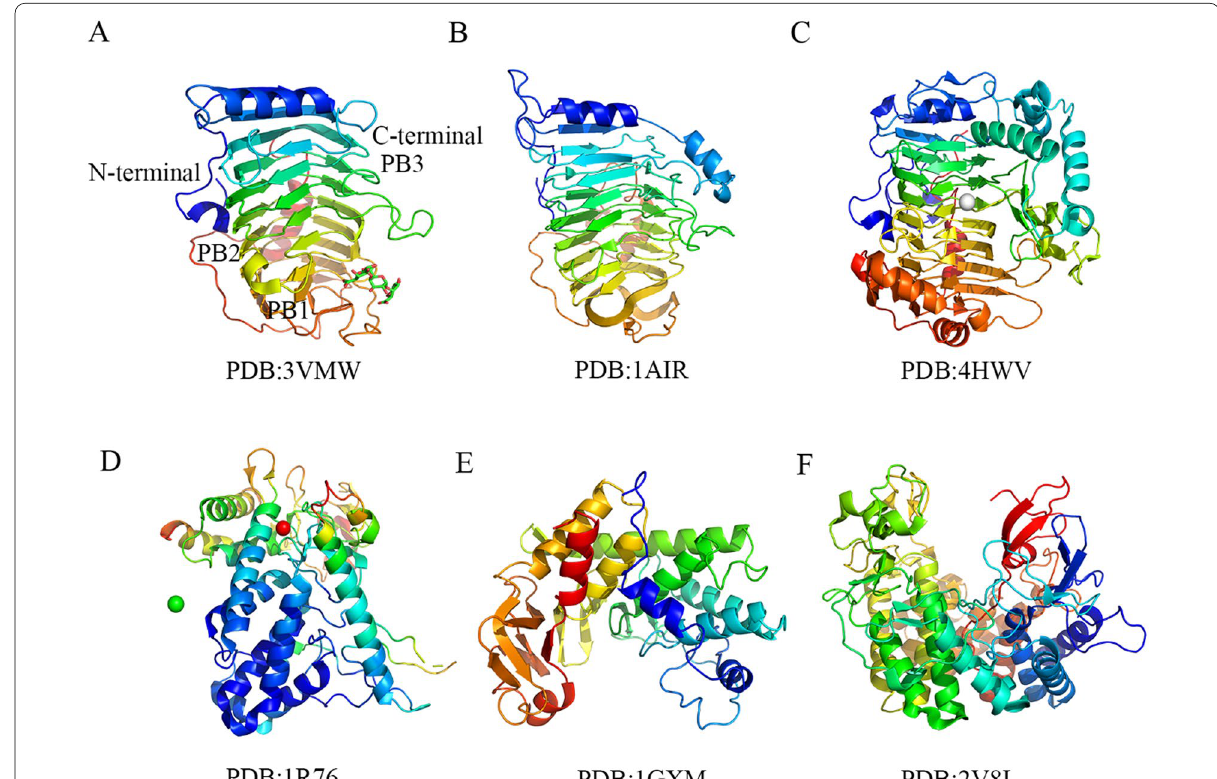
Fig. 3 Three-dimensional structures of PGLs from different PLs families. A – C . The PGL Bsp165PelA, PelE and AcPel from the PL1 family all display typical β-helical structure. The β sheets (PB1, PB2, PB3), N-terminal and C-terminal of Bsp165PelA are marked in Fig. 3A. The white spheres in Fig. 3C are calcium ion. D , E The PGLPelA and Pel10Acm from the PL10 family are (α-α) 3 -barrel structures. The green and white spheres in Fig. 3D are chlorine and mercury ions, respectively. F The PL 2 family PGL YePL2A from Yersinia enterocolitica presents a rare (α-α) 7 -barrel structure; the corresponding PDB is marked below each structure